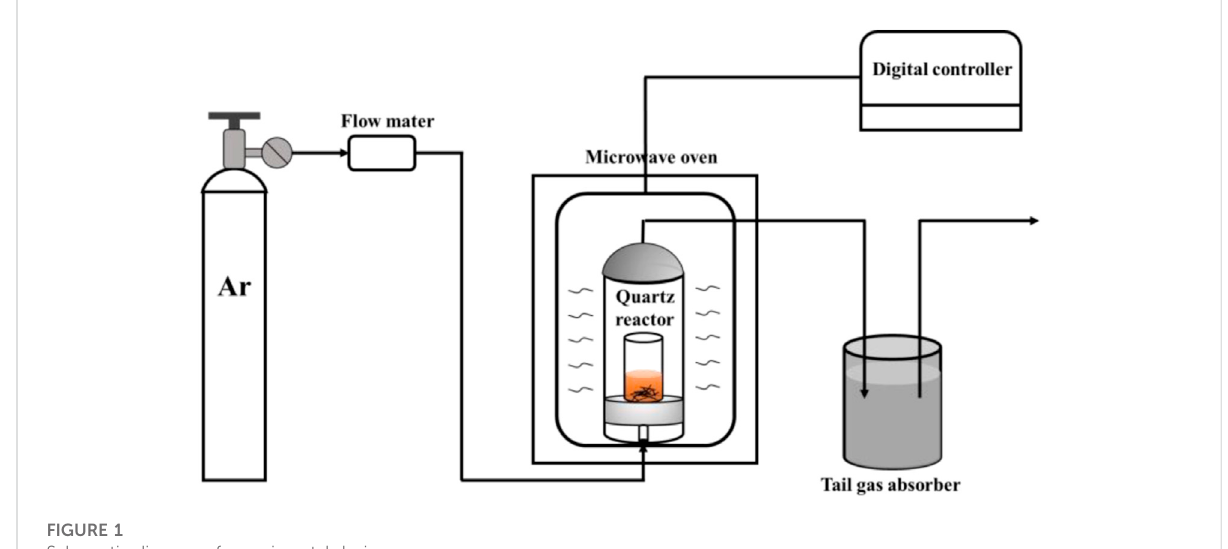
FIGURE 1 Schematic diagram of experimental